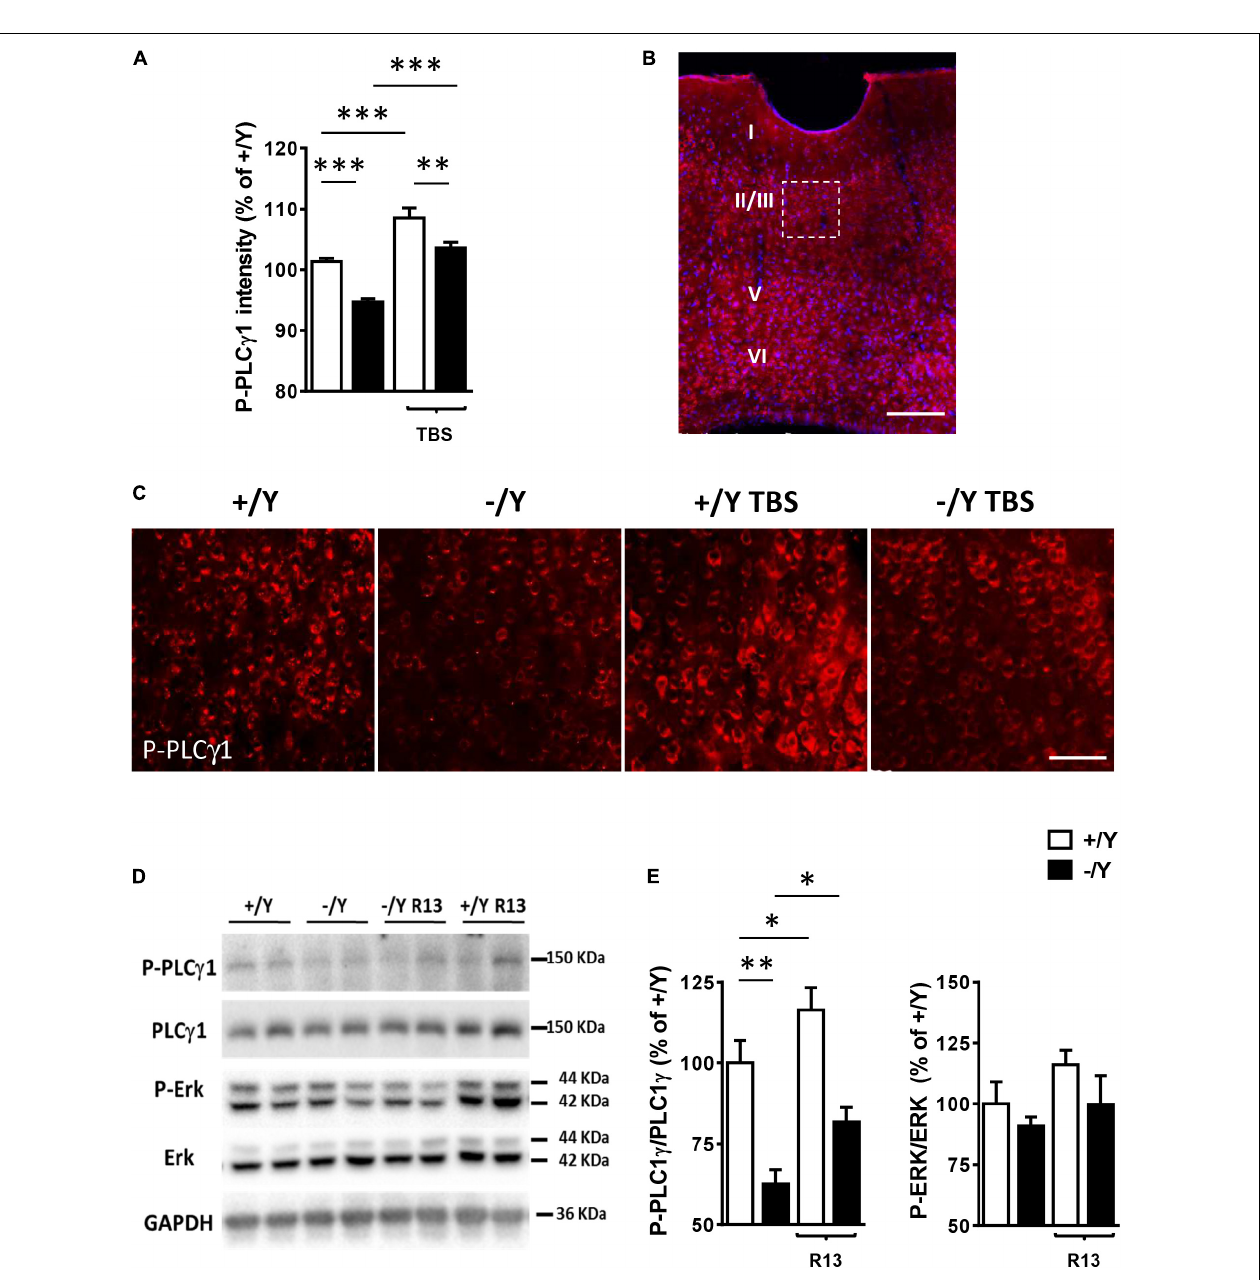
FIGURE 4 | Effect of TBS or treatment with R13 on TrkB/ PLC γ 1 signaling in the perirhinal cortex of Cdkl5 − /Y mice. (A) Quantification of P-PLC γ 1 signal intensity in PRC slices before and after theta burst stimulation (TBS; four trains every 15 s, each train comprising 10 bursts of 5 pulses at 100 Hz, inter-burst interval 150 ms) of Cdkl5 +/Y ( n = 4) and Cdkl5 − /Y ( n = 4) mice. (B) A representative image of PRC processed for fluorescent P-PLC γ 1 immunostaining (red) of a wild-type (+/Y) mouse. Nuclei are stained with Hoechst (blue). The dotted box indicates the region shown at a higher magnification in (C) . Scale bar = 50 µ m. Roman numerals indicate PRC cytoarchitectonic layers. (C) Representative images of layer II-III PRC neurons of Cdkl5 +/Y and Cdkl5 − /Y PRC slices as in (A) . (D,E) Quantification of PLC γ 1 and Erk phosphorylation levels before and after treatment with R13. Cdkl5 − /Y and Cdkl5 + /Y mice were treated for 15 days (5 mg/Kg IP) from postnatal day 35 (P35) to 50 (P50), the day of sacrifice. Western blot examples (D) and analyses (E) of P-PLC γ 1 (Tyr783), PLC γ 1, P-Erk and Erk levels in PRC homogenates of vehicle-treated Cdkl5 + /Y ( n = 5) and Cdkl5 − /Y ( n = 5) mice, and R13-treated Cdkl5 + /Y ( n = 6) and Cdkl5 − /Y ( n = 6) mice. Values represent mean ± SE. ∗ p < 0.05; ∗∗ p < 0.01; ∗∗∗ p < 0.001 (Fisher’s LSD test after two-way